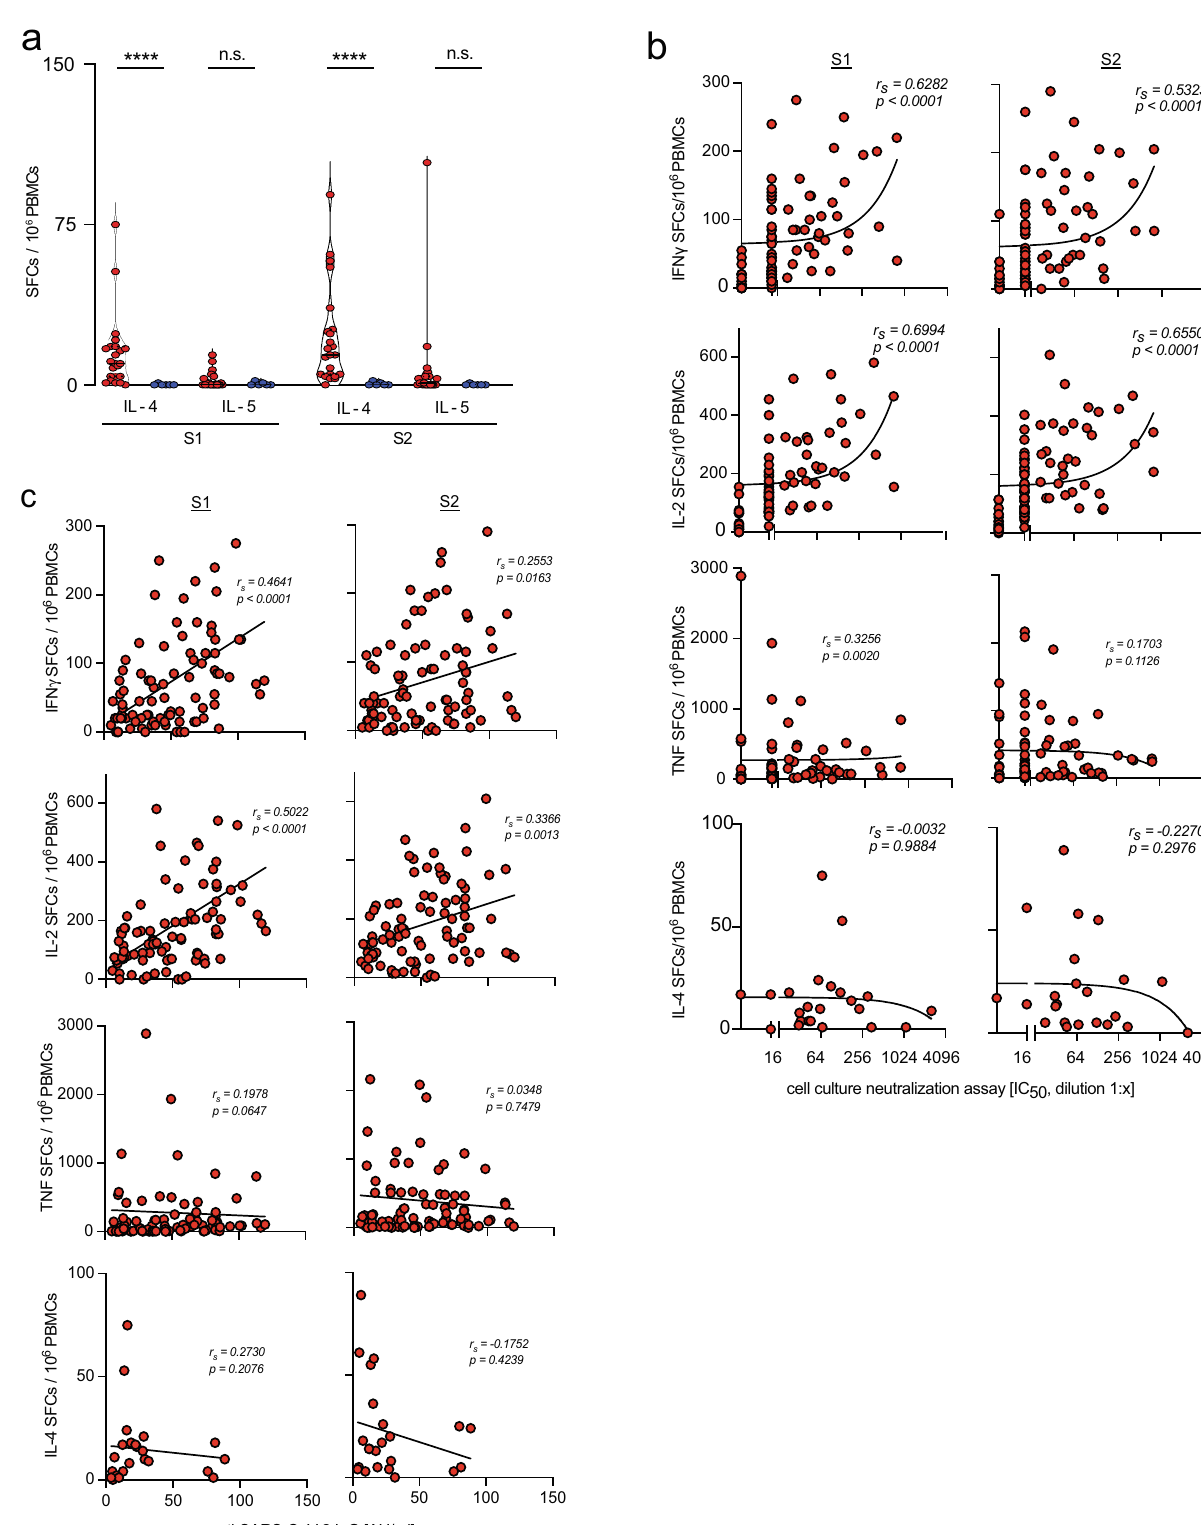
Fig. 3 Frequencies of IL-2 and IFN γ -secreting but not IL-4 secreting cells correlate with virus-neutralization activity in SARS-CoV-2 convalescents. a Frequencies of spike-reactive IL-4- or IL-5-secreting cells in convalescents (red, n = 23) or naïve individuals (blue, n = 6). b , c Correlation of frequencies of S1- or S2-reactive IFN γ -, IL-2-, TNF-, or IL-4-secreting cells with virus-neutralization activity or anti-SARS-CoV-2 IgG in convalescents. Statistical analyses by two-sided Mann – Whitney test ( a ), Spearman correlation and linear regression ( b , c ); r s denotes Spearman correlation coef fi cient; n.s. denotes not signi fi cant; **** p <